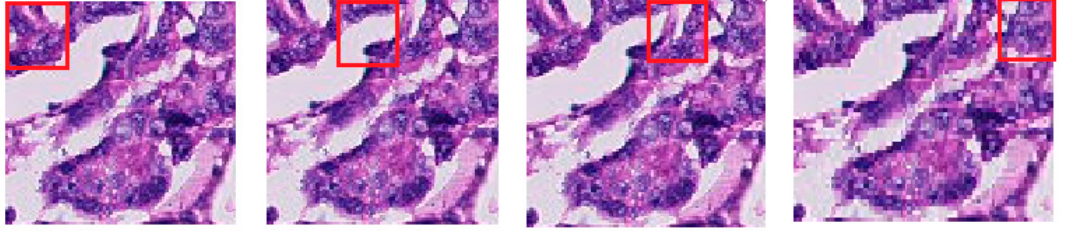
Figure 3. Convolution filter to extract features.